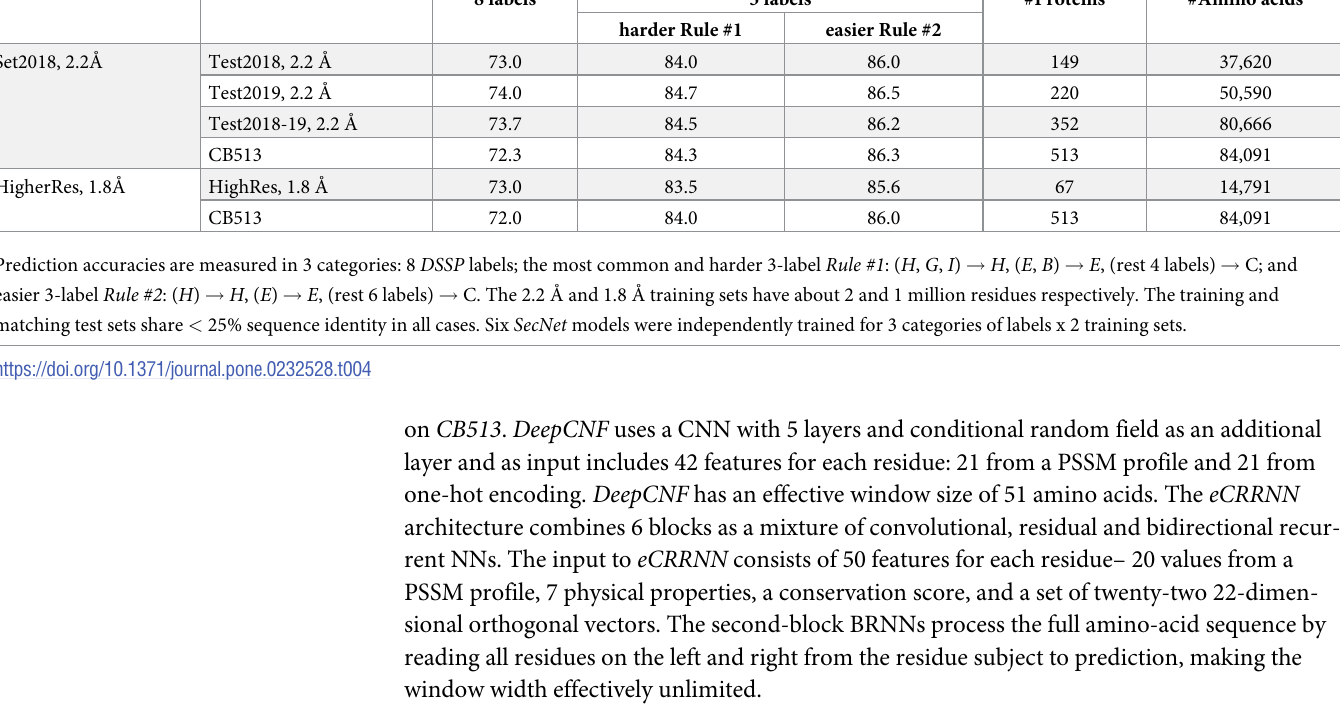
Table 4. Prediction accuracy of our SecNet software in 3 categories of labels on 5 test sets. Training set Testing set